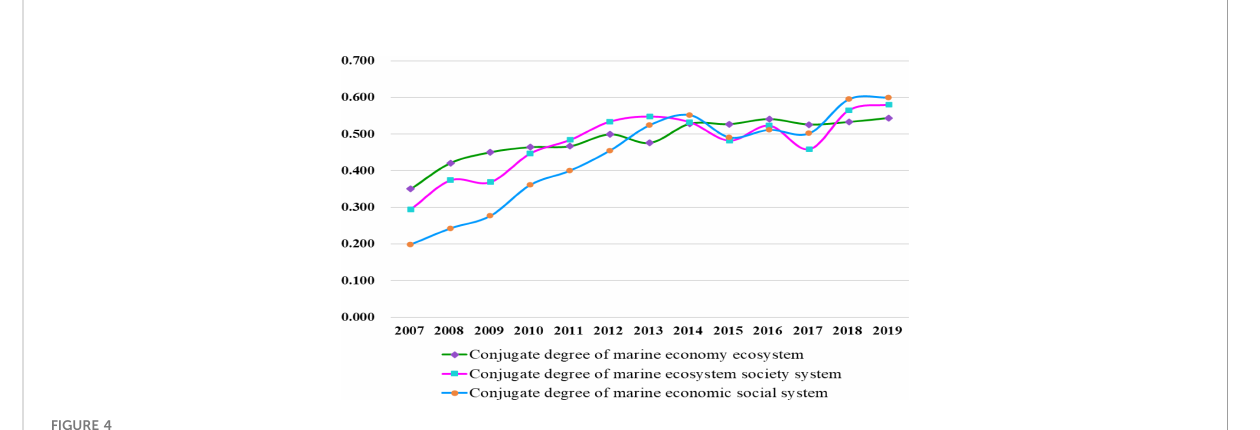
FIGURE 4 Conjugate degree among subsystems of marine composite system in Shandong Province from 2007 to